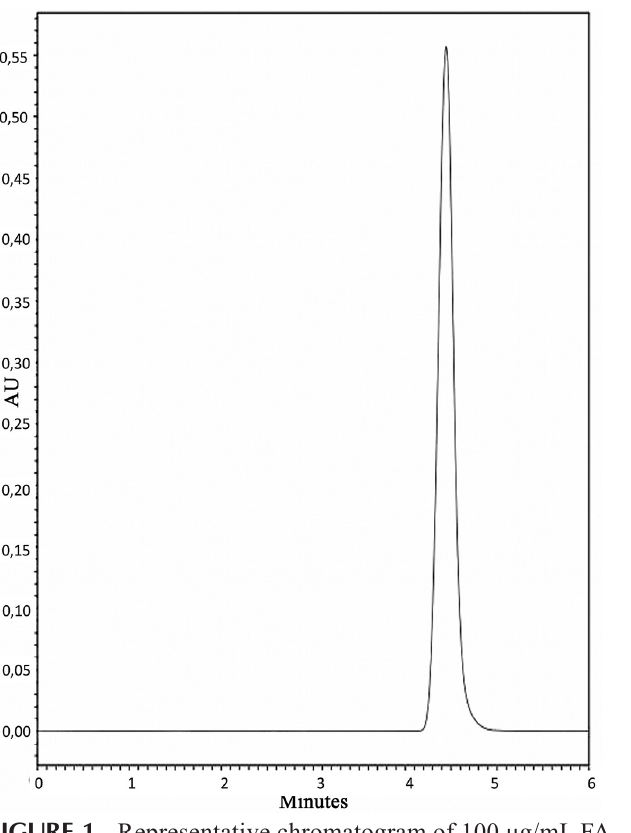
FIGURE 1 - Representative chromatogram of 100 μg/mL FA standard solution. Mobile phase: acetonitrile:0.5% acetic acid (37:63 v/v), flow rate: 1.0 mL/min, λ: 320 nm.